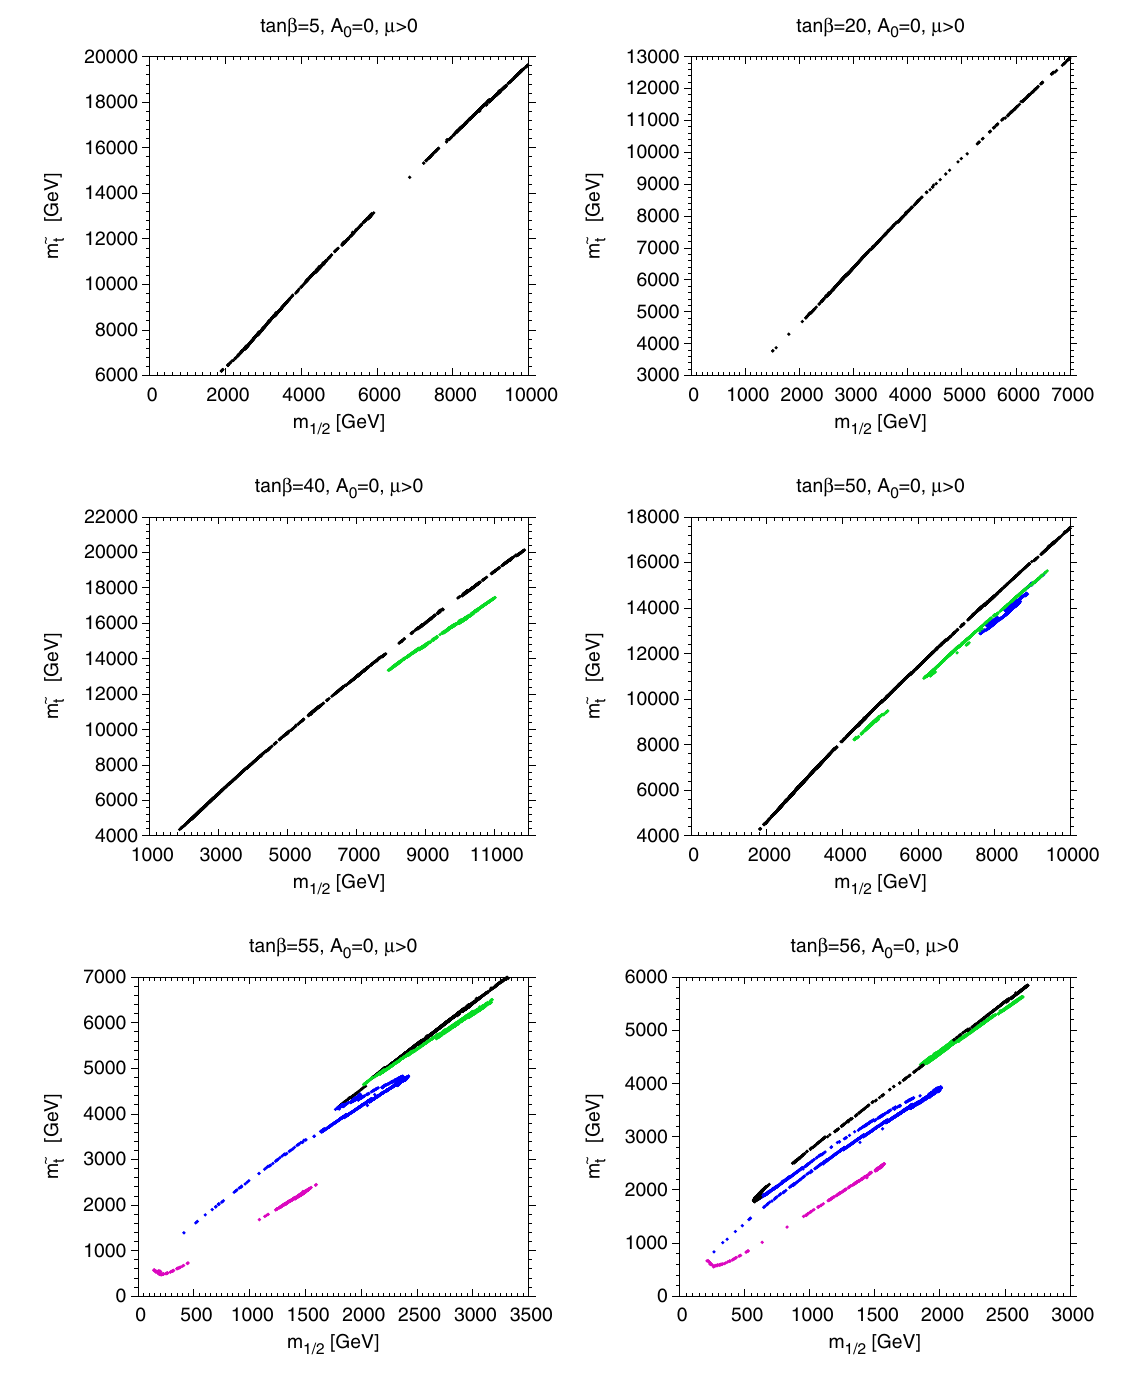
Fig. 6 The lighter stop mass along the dark matter strips for tan β = 5 , 20 , 40 , 50 , 55 and 56, with A 0 = 0 and μ > 0